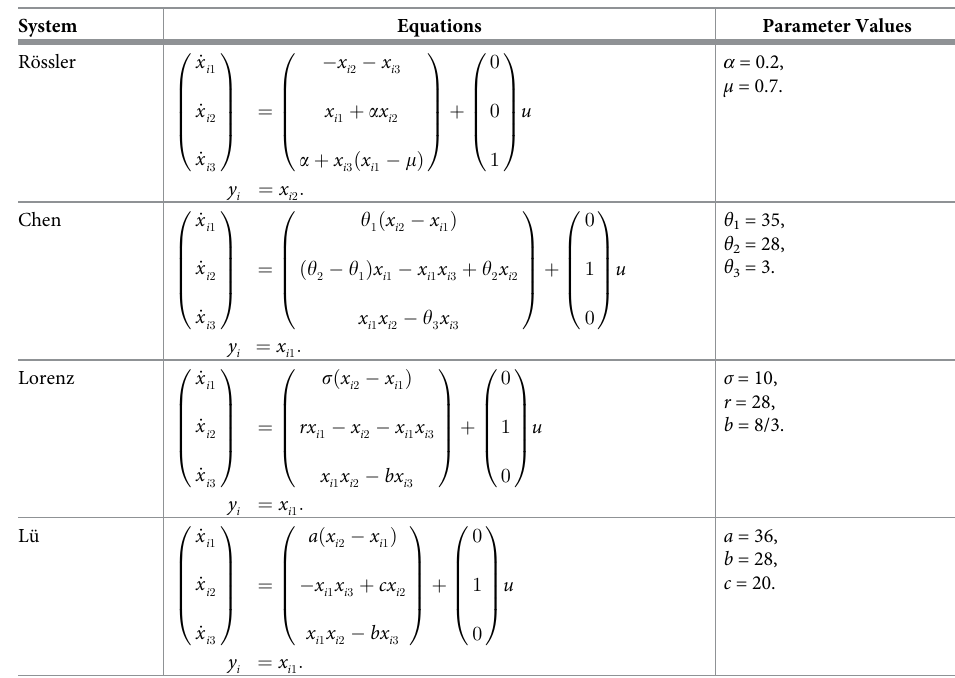
Table 1. Chaotic systems and parameter